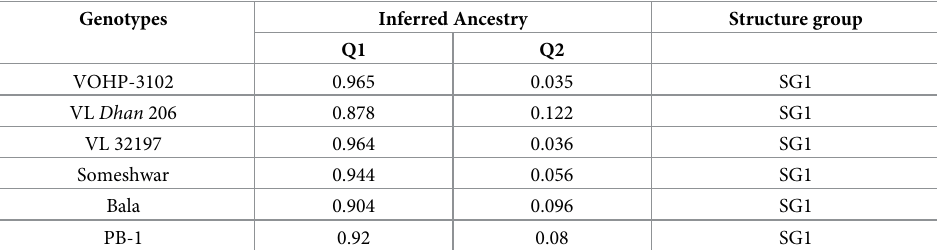
Table 7. Percentage of variation explained by the first 3 axes using blast resistance gene in PCoA. Axis 1 2 3 Variation of the individual axis (%) 17.18 12.29 9.21 Cumulative variation (%) 17.18 29.47 38.67